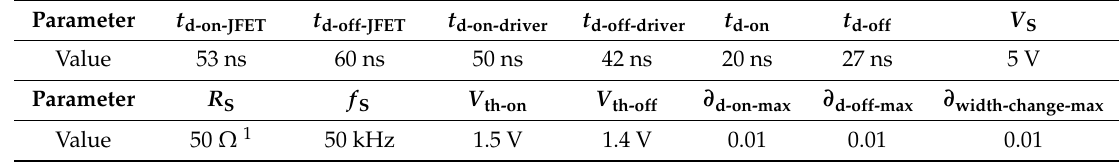
Table 1. Model parameters of the double-pulse test circuit.